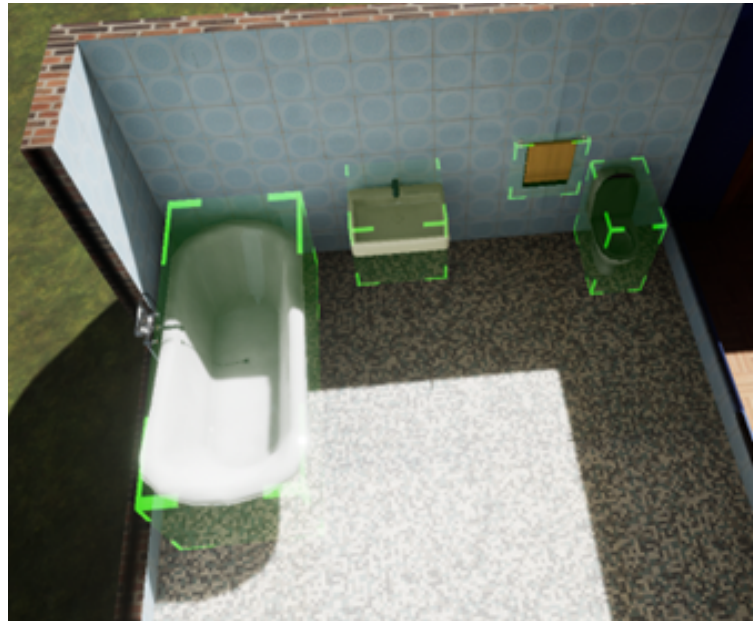
Figure 3. Interactive objects highlighted in the bathroom.